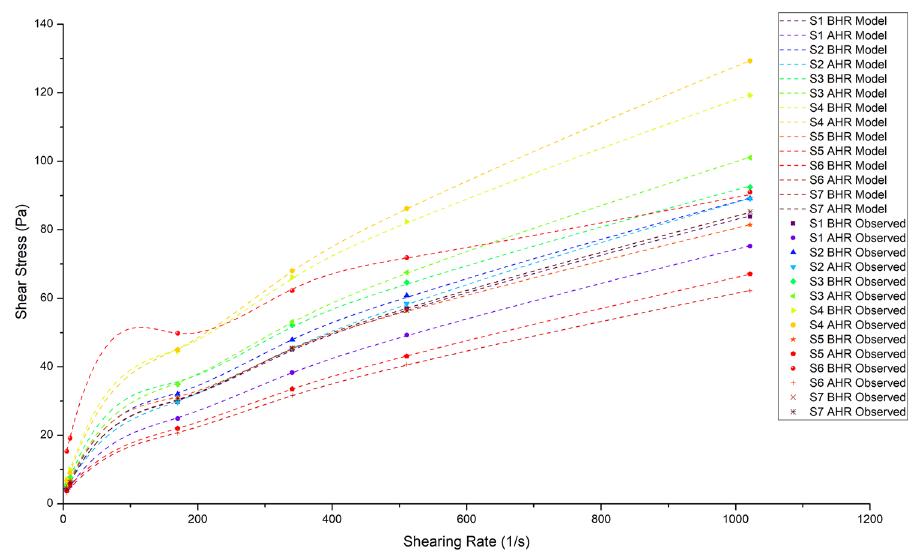
Fig. 10 Stress versus shearing rate of S1–S7